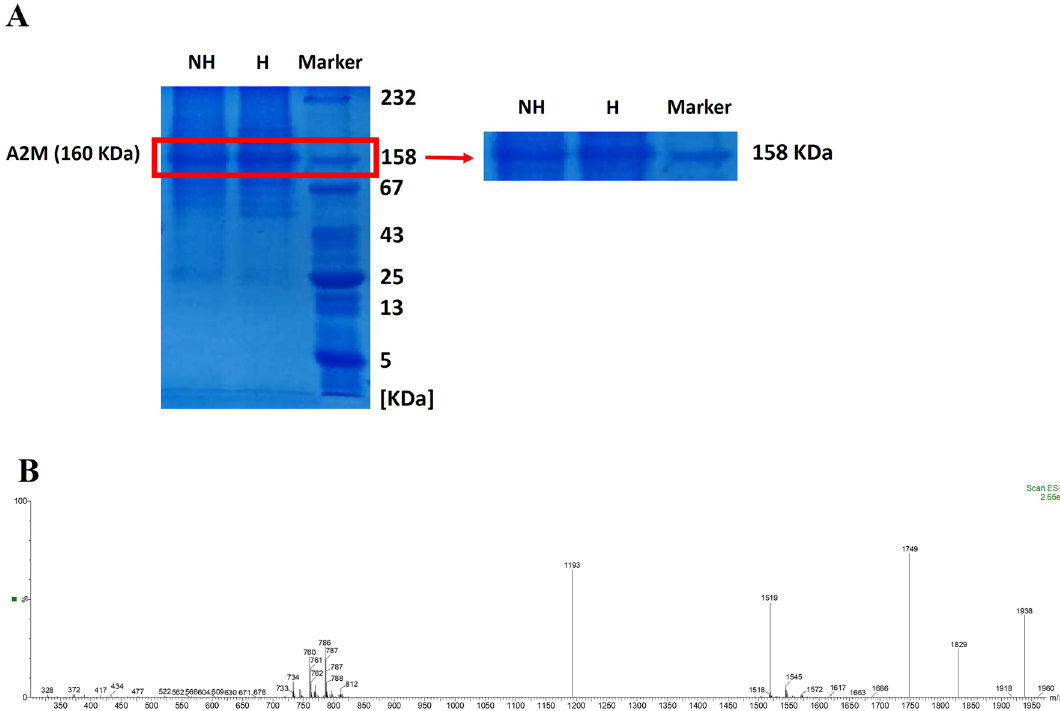
Figure 8. Analysis of plasma proteins by ( A ) SDS-PAGE (12%) and ( B ) identification with mass spectrometry (HPLC–ESI–MS). (Marker: Molecular weight marker of the proteins, NH: Non-hibernating Common carp plasma, H: Hibernating Common carp plasma, A2M: